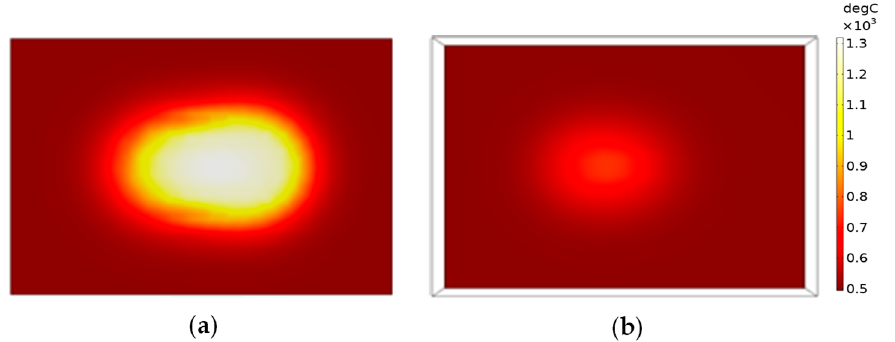
Figure 6. Temperature changes during one area scan. ( a ) Top surface; ( b ) bottom surface.